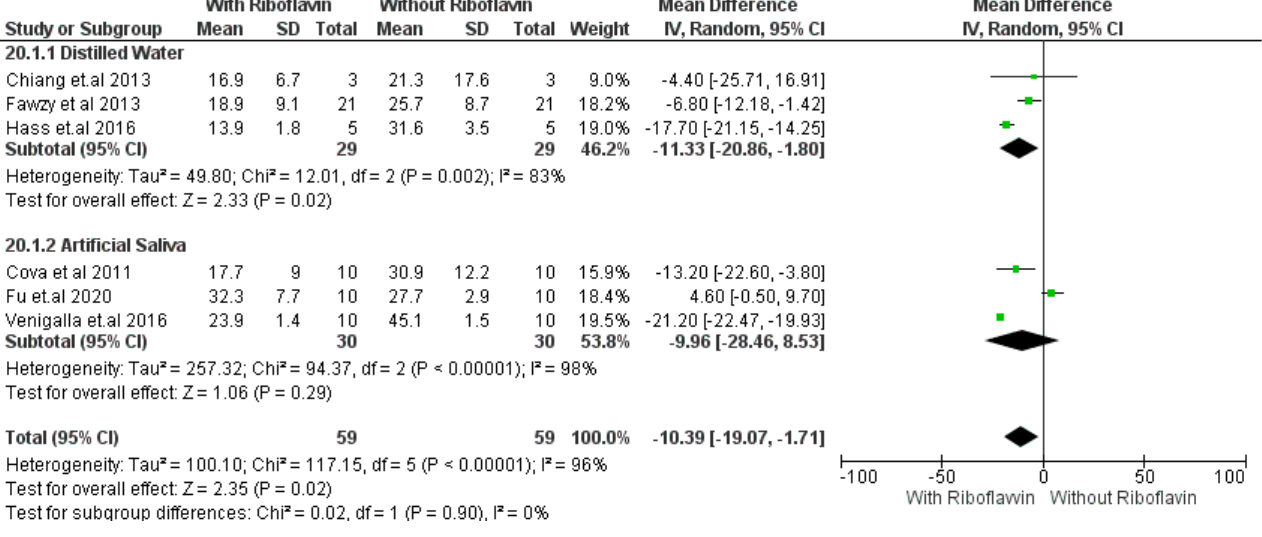
Figure 4. Subgroup analysis of micro tensile strength property of adhesive using 0.1% RF-cross- linker [18,23,26,30,33,34]. crosslinker